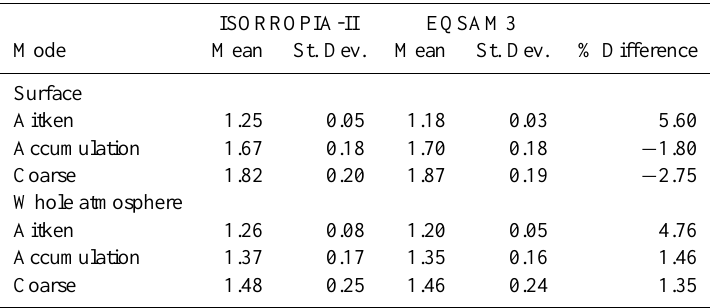
Fig. 16. Observed and modelled (with EQSAM3) annual average concentrations (in µgm − 3 ) for the year 2001 of nitrate (top row), ammo- nium (middle) and sulfate (lowest row) compared to observational data. Left column: CASTNET (star) and IMPROVE (triangle); middle column: EMEP; right column: EANET. Dashed lines indicate the 1:2 and 2:1ratios. Table 7. Summary of the annual mean hygroscopic growth factors (GF=wet radius/dry radius) for the simulation using ISORROPIA-II and EQSAM3. Analysis considers (i) the surface layer only and (ii) all vertical